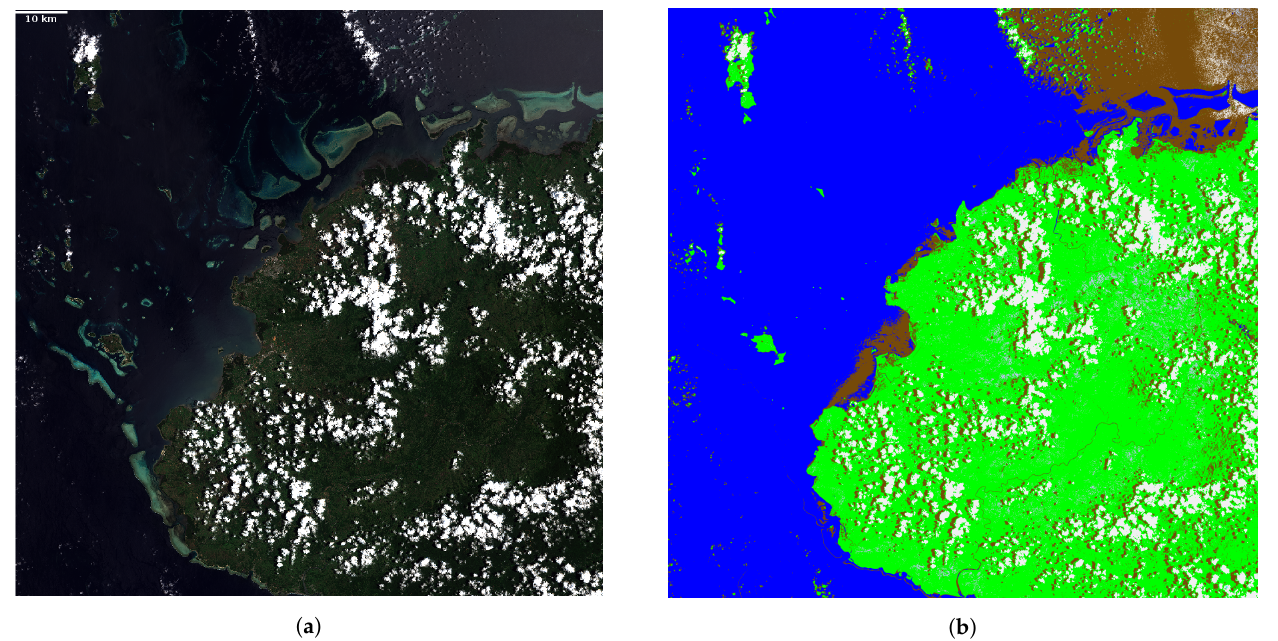
Figure A2. ( a ) L1C product ( b ) RGB Scene classified image using developed package. Labels—Water as Blue, Shadow as Brown, Cirrus as light Purple, Cloud as White, Snow as Cyan and Other as